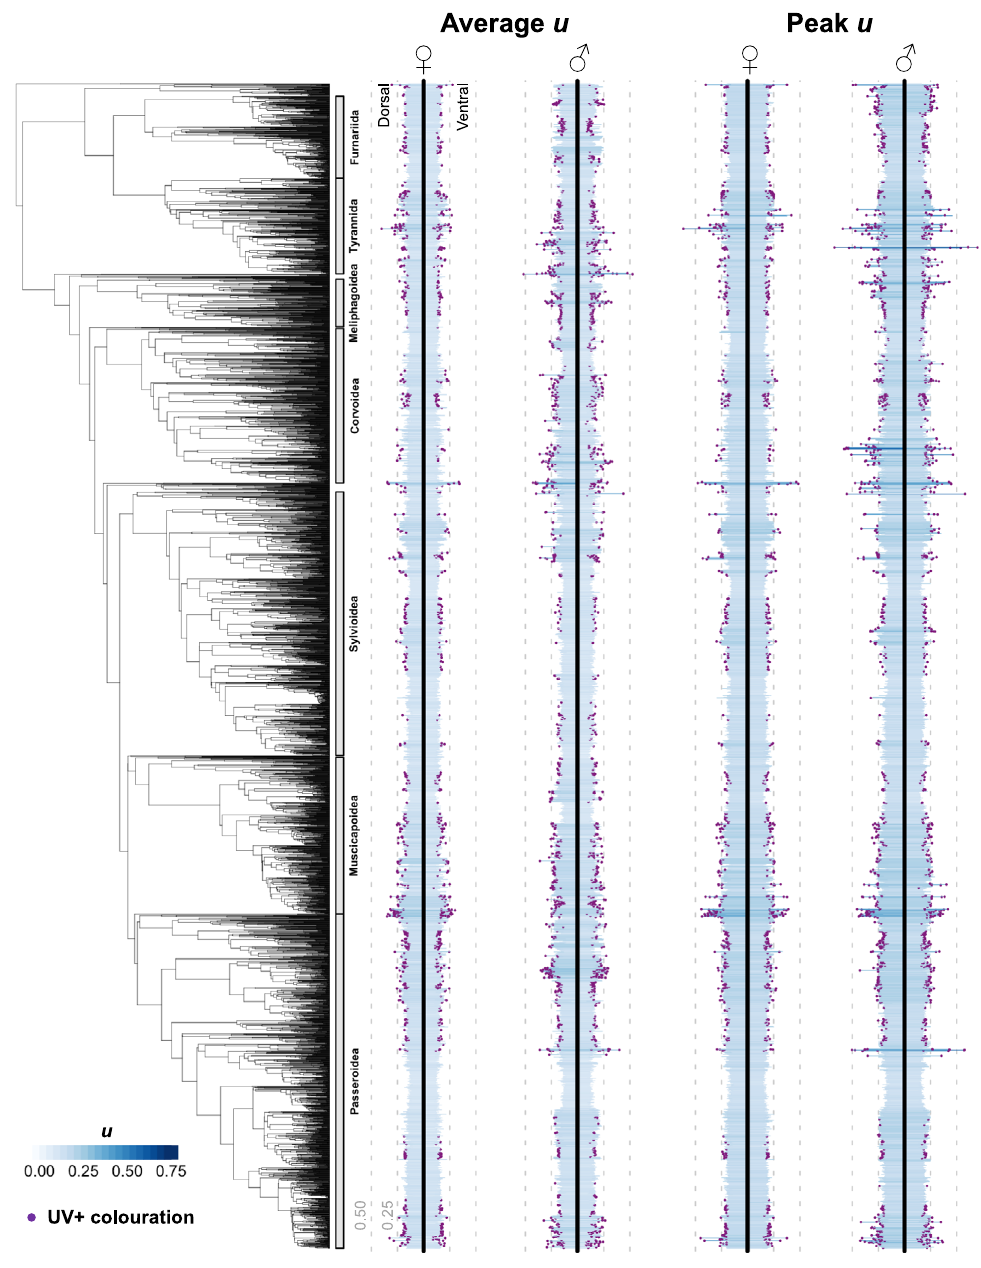
Fig.3|ThephylogeneticdistributionofUVcolourationinpasserinebirds. Blue bars indicate the relative contribution of ultraviolet re fl ectance to plumage